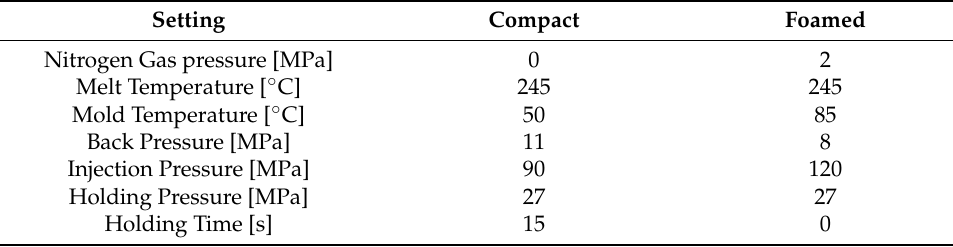
Table 2. Processing conditions for the IM trials.